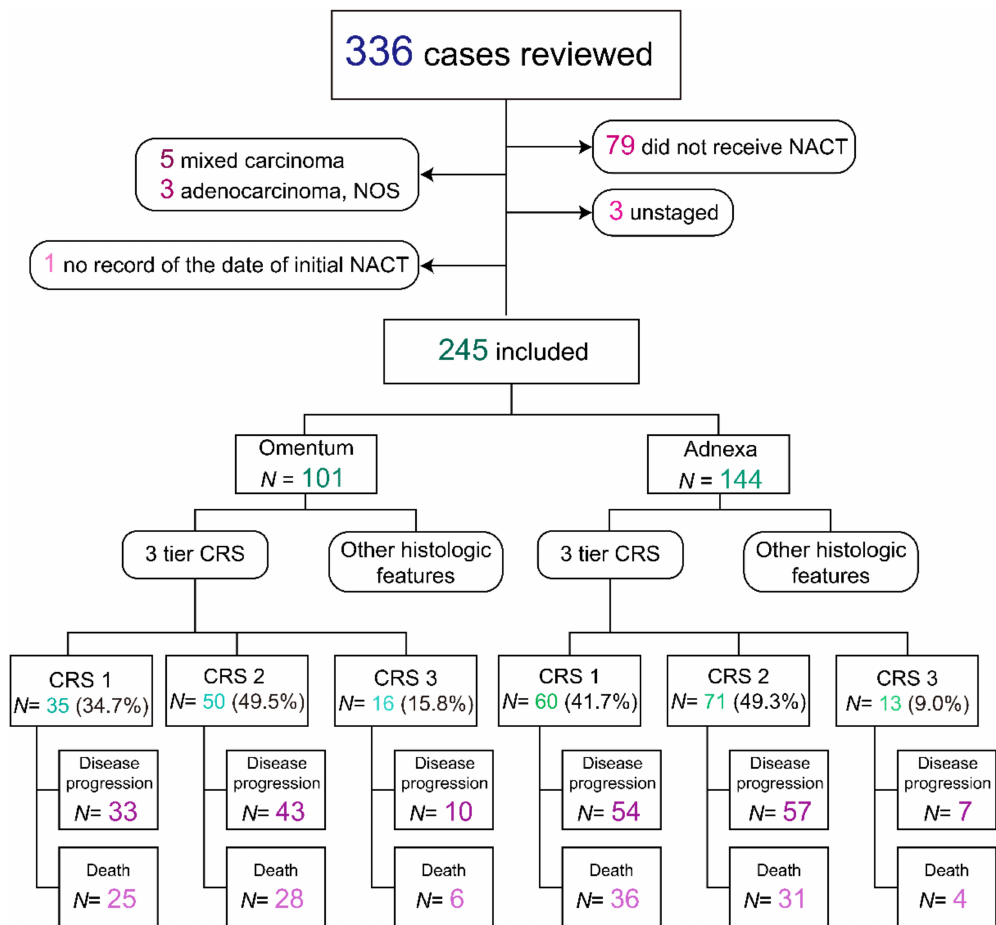
Figure 1. Overview of the study cohort. Of 336 patients with extrauterine carcinoma, 91 patients were excluded because patients did not receive neoadjuvant chemotherapy (NACT) ( N = 79), tumor histology was not high-grade serous carcinoma (HGSC) ( N = 8), staging information was not available ( N = 3), or the date of initial NACT was unknown ( N = 1). We included the remaining 245 patients in our analysis. Chemotherapy response score,